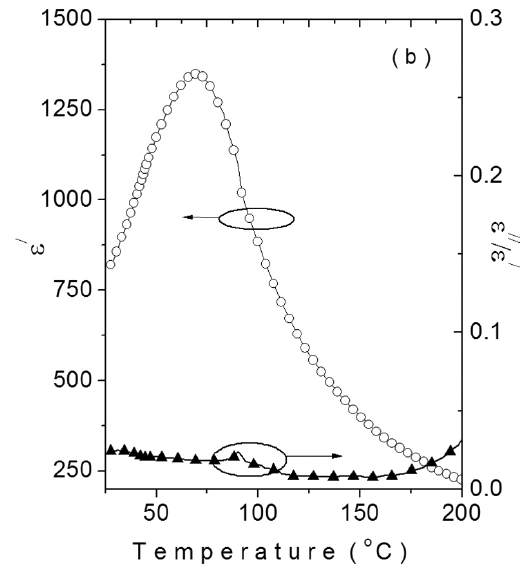
Figure 7. Temperature dependence of the dielectric constant and dielectric loss ( ε // / ε / ) at 1kHz. The thick films were deposited with EtOH+Acac suspension, nanoparticles concentration of 5 mg/cm 3 , deposition time of 120s, electric field of 133V/cm and sintered at 1220